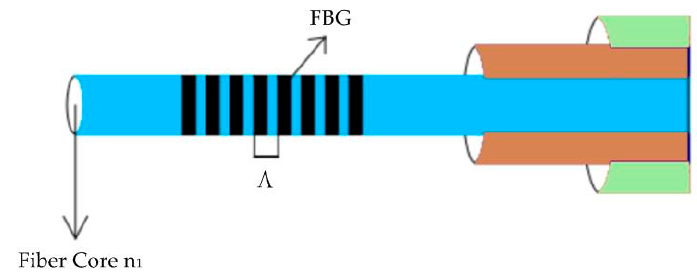
Figure 7. Schematic diagram of fiber Bragg grating (FBG) sensor structure.